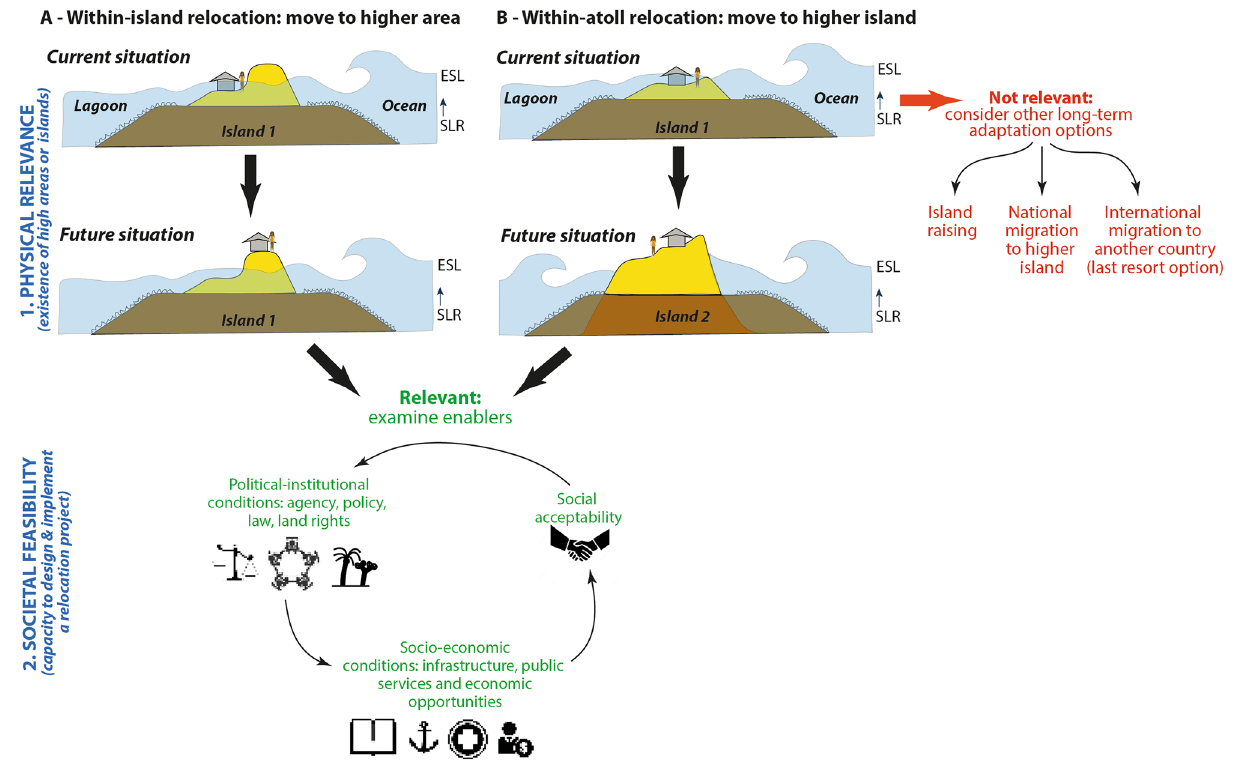
Figure 1. Approach of internal relocation in atoll contexts. Here, internal relocation includes moving either to a higher area on the same atoll island ( A ), or to a higher island ( B ) within the same atoll. If none of these two options are available, other long-term adaptation options should be considered, including island raising and national migration to higher distant islands or, as a last resort, abroad (international migration). If option A or B is available, internal relocation is a relevant adaptation option, and its feasibility, which relies on political- institutional and socio-economic conditions, as well as on social acceptability, should be assessed. ESL, extreme sea level. SLR, sea-level